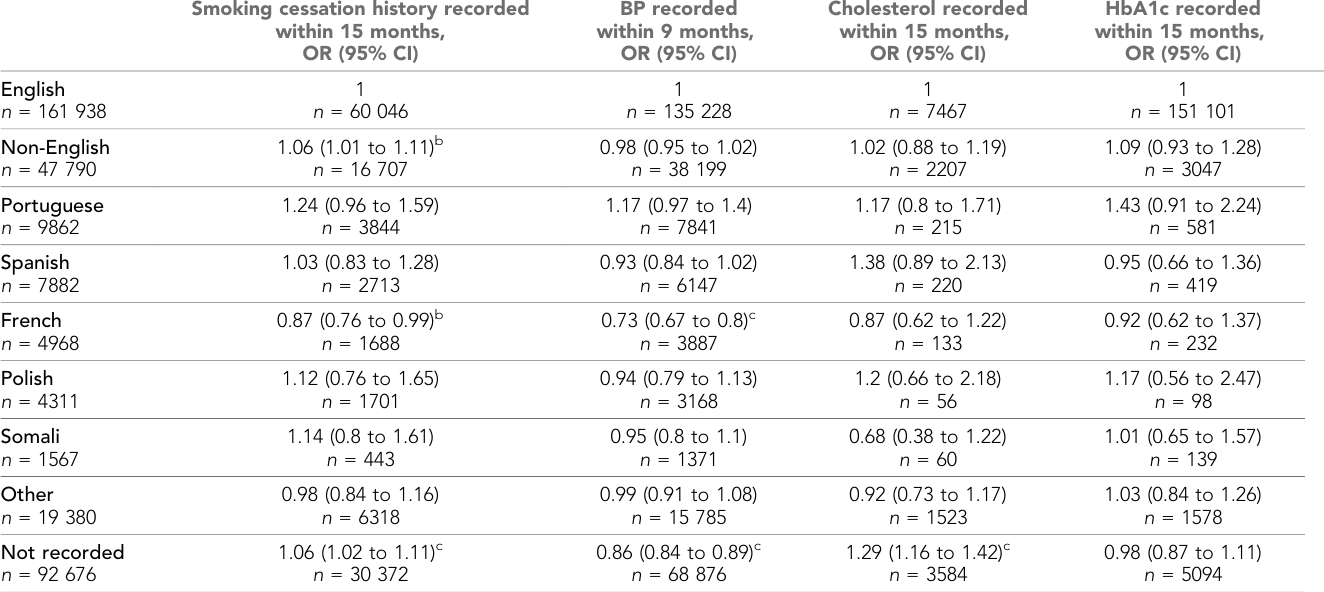
Table 4. Association between cardiovascular monitoring recorded within a set interval and language preference (adjusted a ORs with 95% confidence